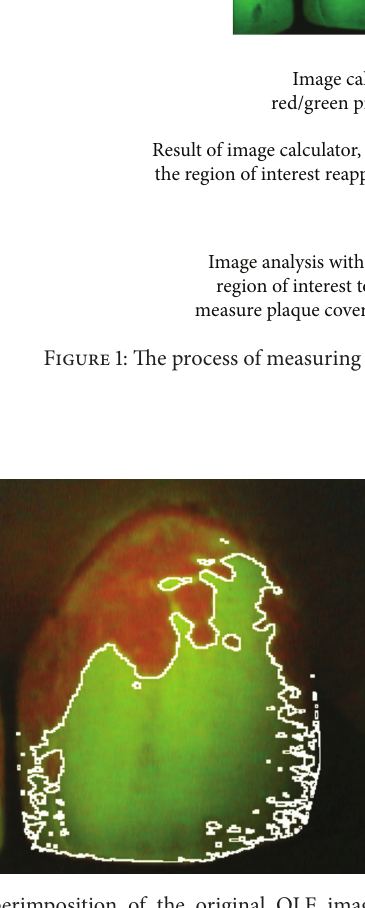
Figure 2: Superimposition of the original QLF image and the boundary between the areas with and without plaque as determined